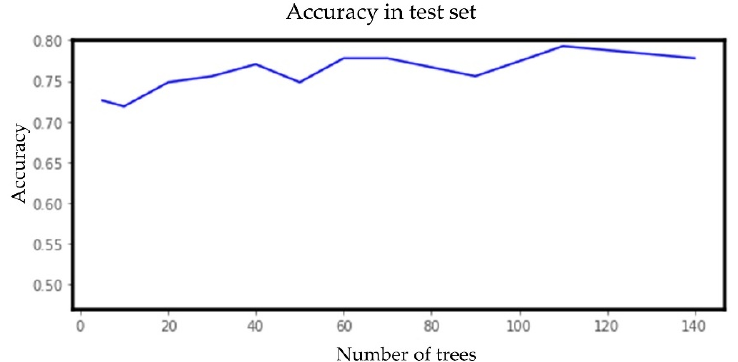
Figure 12. Accuracy vs. number of estimators (trees) for the random forest model for the early well-child visit scenario.